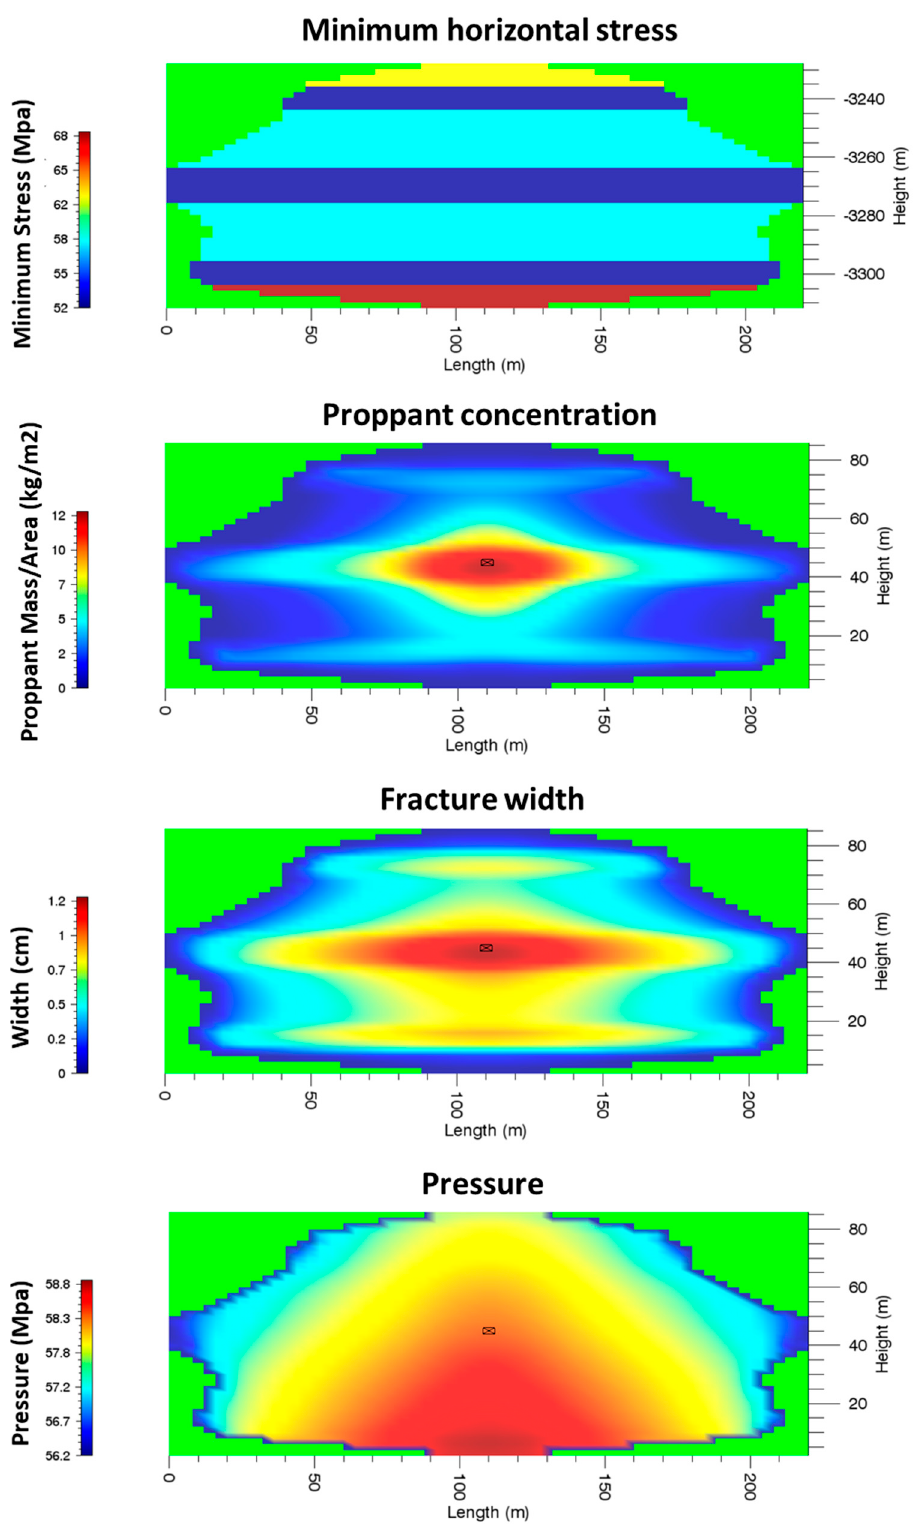
Figure 13. The stress profile, fracture width, proppant concentration and fluid pressure across the fracture of Case 2.